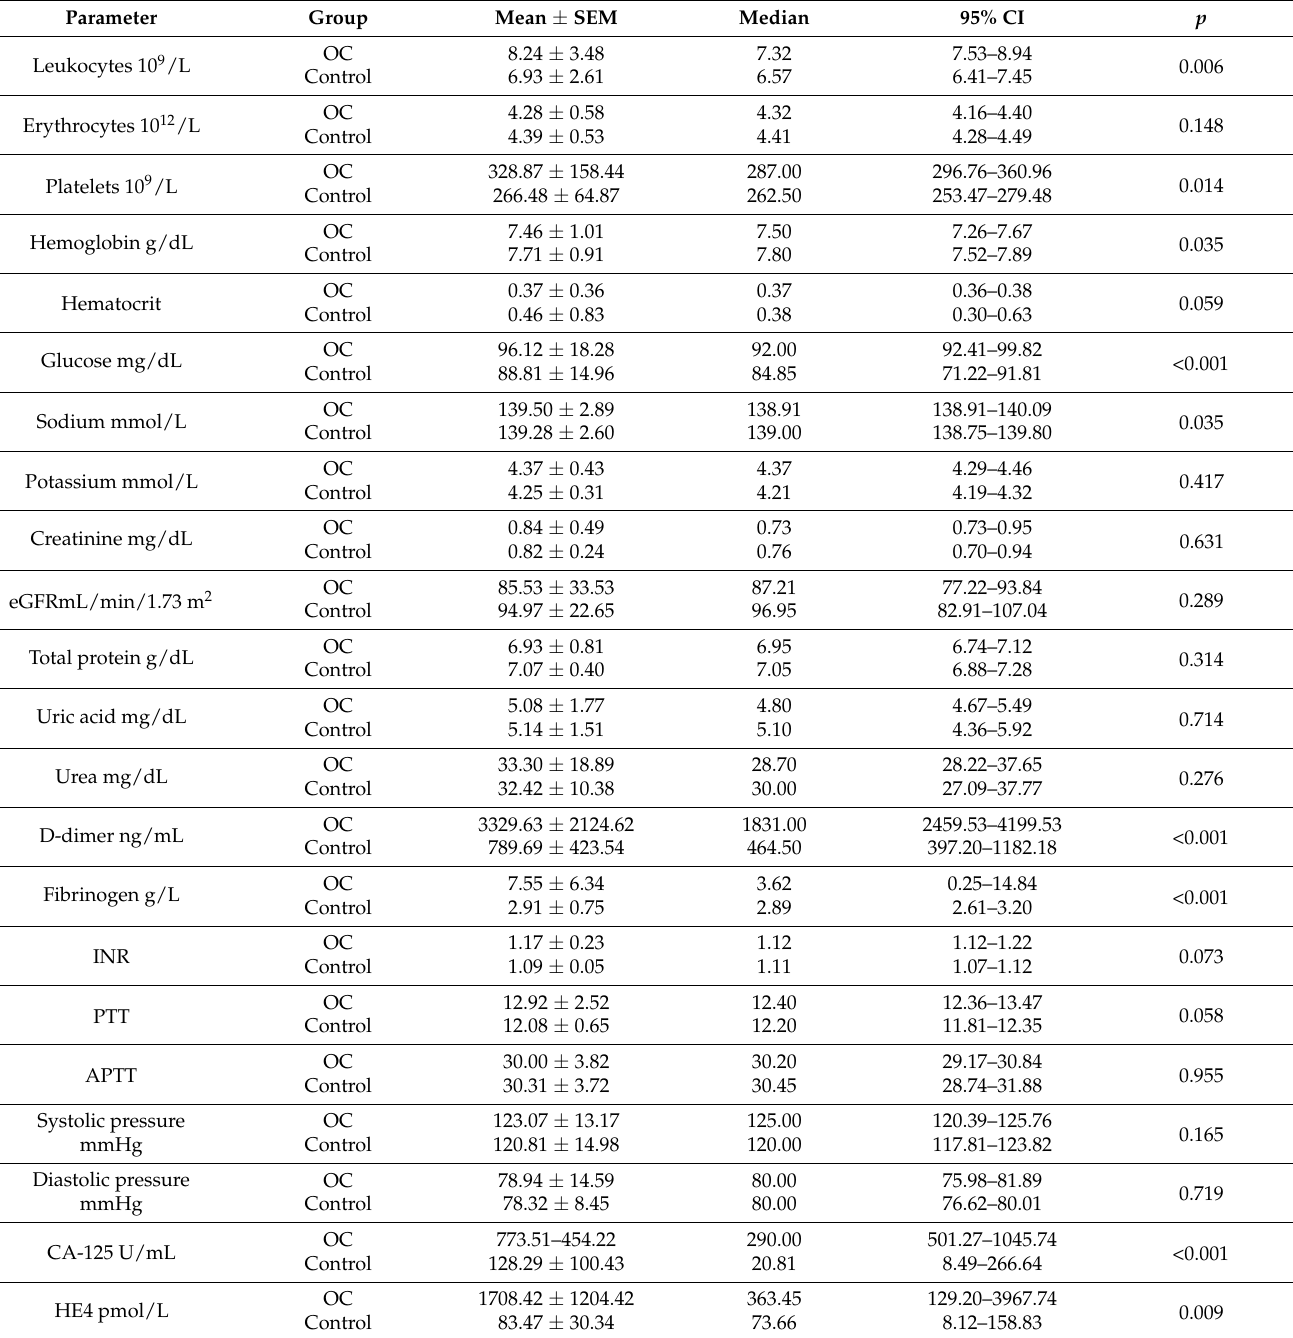
Table 2. Comparison of selected clinical and biochemical parameters between women with ovarian cancer and control